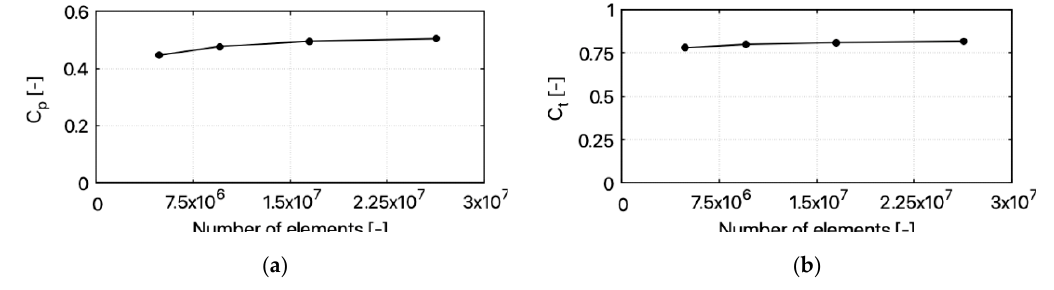
Figure 5. C p ( a ), C t ( b ) and C t ( c ) change with increase of grid’s resolution. Table 1. The mesh independence test.